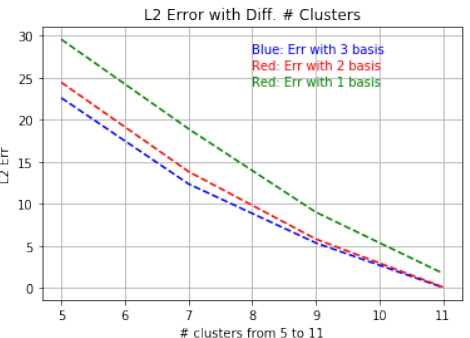
Figure 10. The l 2 error when the number of clusters changes, colors represent the number of GMsFEM